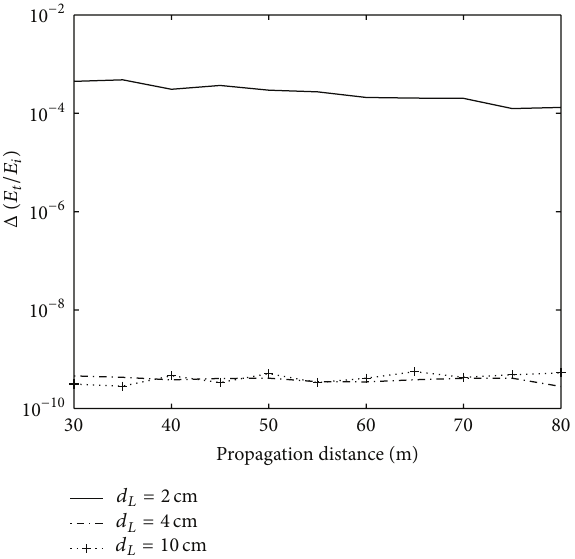
Figure 7: The phase shift as function of the number of layers of thickness 20 cm. With dashed line we presented results correspond- ing to variations in the concentration of calcium and with dotted line—concentration of titanium.